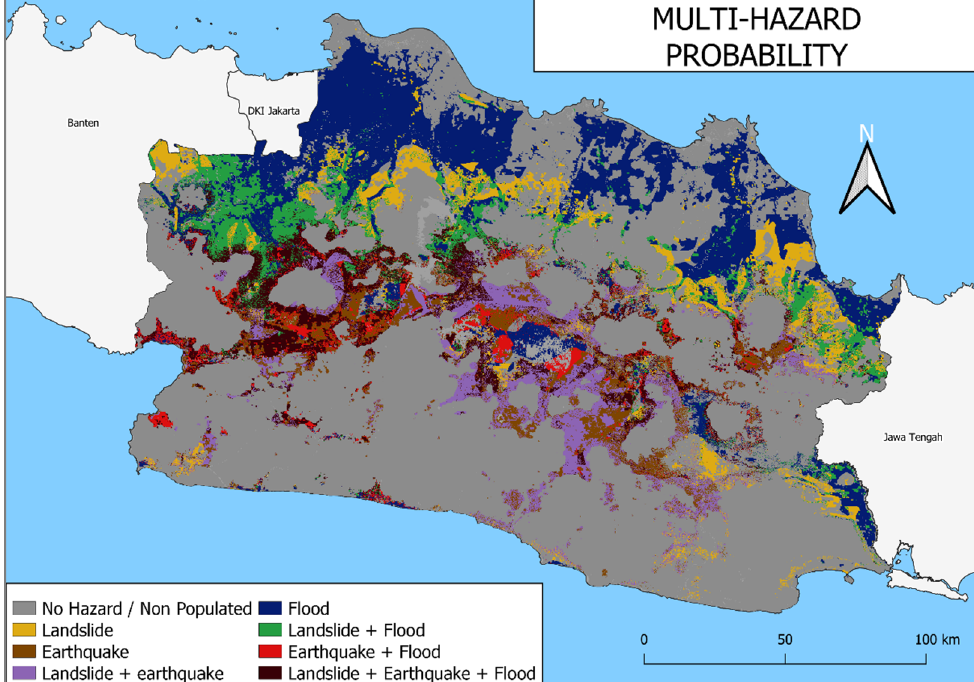
Figure 8. Multi-hazard probability map of landslides, earthquakes, and floods.